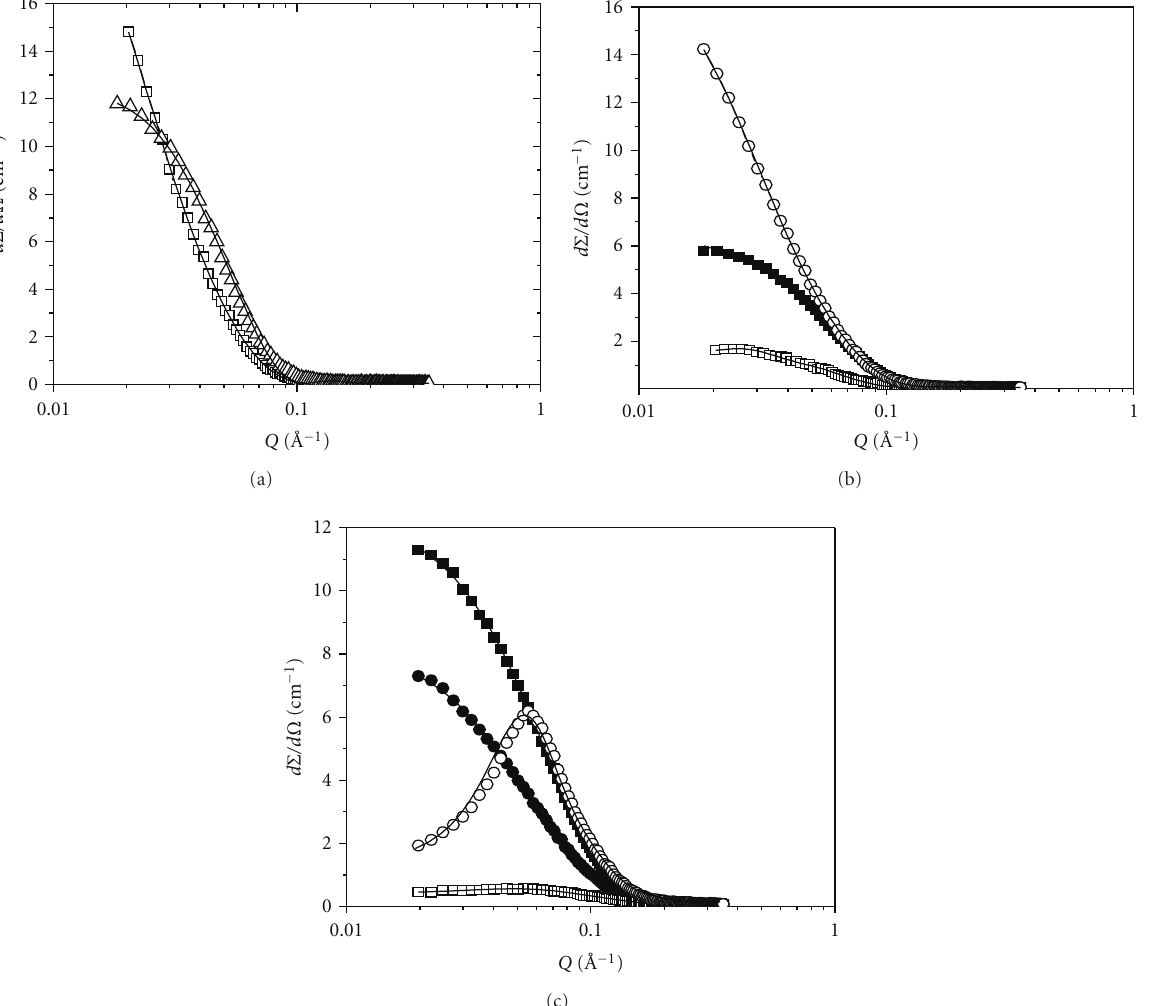
Figure 2: SANS distribution for copolymer or surfactant solution in D 2 O at di ff erent temperatures (in ◦ C) (a) 2% (w/v) B-1: ( (cid:2) ) 30 ◦ C, ( (cid:3) ) 50 ◦ C; (b) 2% (w/v) B-1: ( (cid:3) ) (30 ◦ C), ( (cid:4) ) 50 ◦ C, ( (cid:4) ) 70 ◦ C; (c) ( (cid:4) ) 2.4% SDS at 30 ◦ C, ( (cid:3) ) 1% DTAB 30 ◦ C, ( • ) 3% and ( (cid:4) ) 6% TX-100 at 30 ◦ C. Curves represent the model fitted